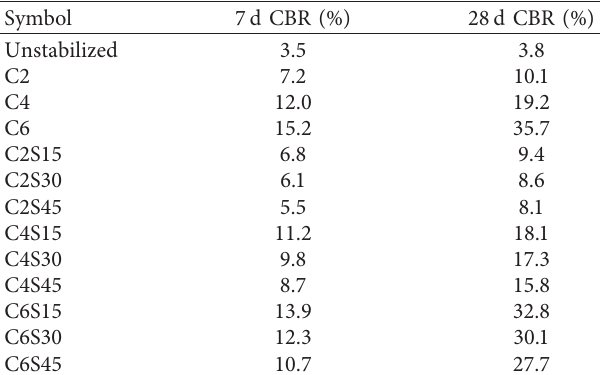
Table 6: CBR values of representative samples.